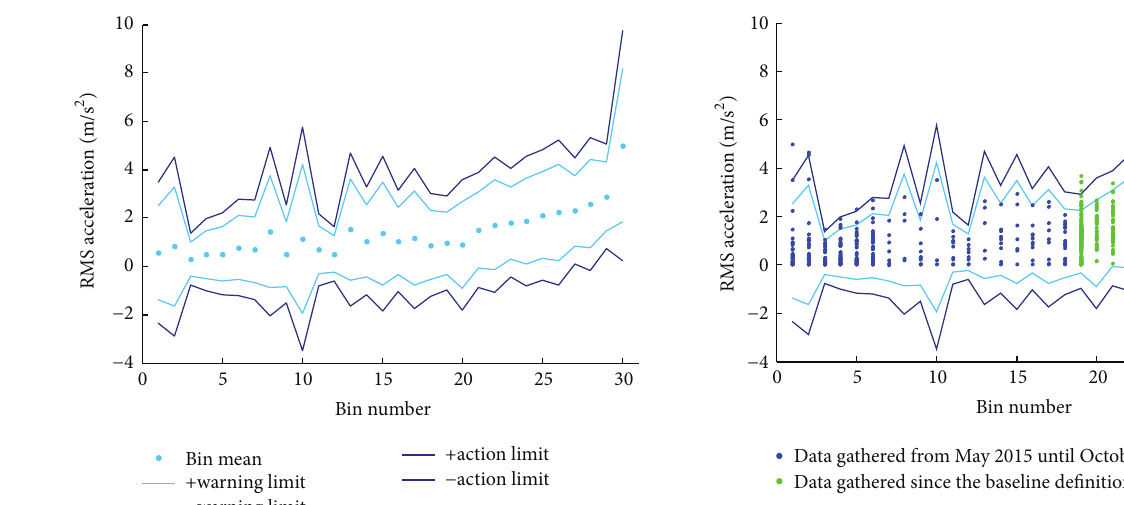
Figure 18: Baseline and targeted mean for a Vestas V90-3MW wind turbine.